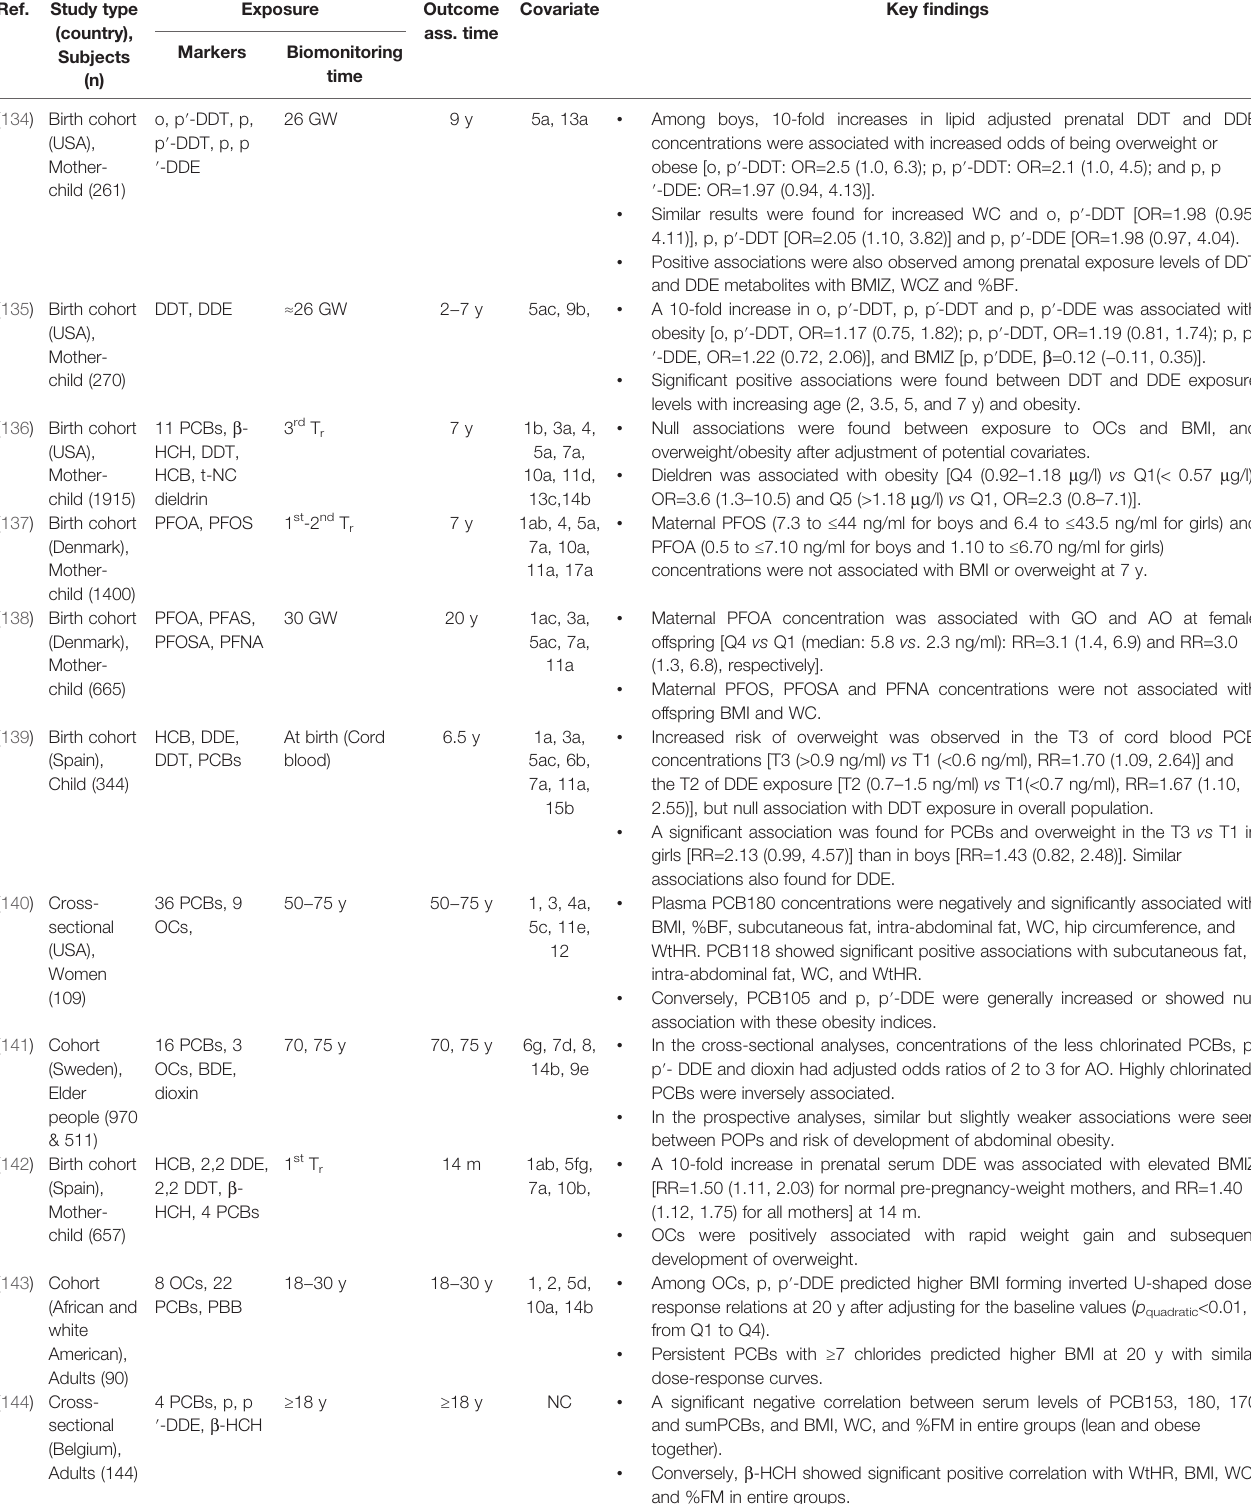
from Q1 to Q4). (cid:129) A signi fi cant negative correlation between serum levels of PCB153, 180, 170 and sumPCBs, and BMI, WC, and %FM in entire groups (lean and obese together). (cid:129) Conversely, b -HCH showed signi fi cant positive correlation with WtHR, BMI, WC, and %FM in entire